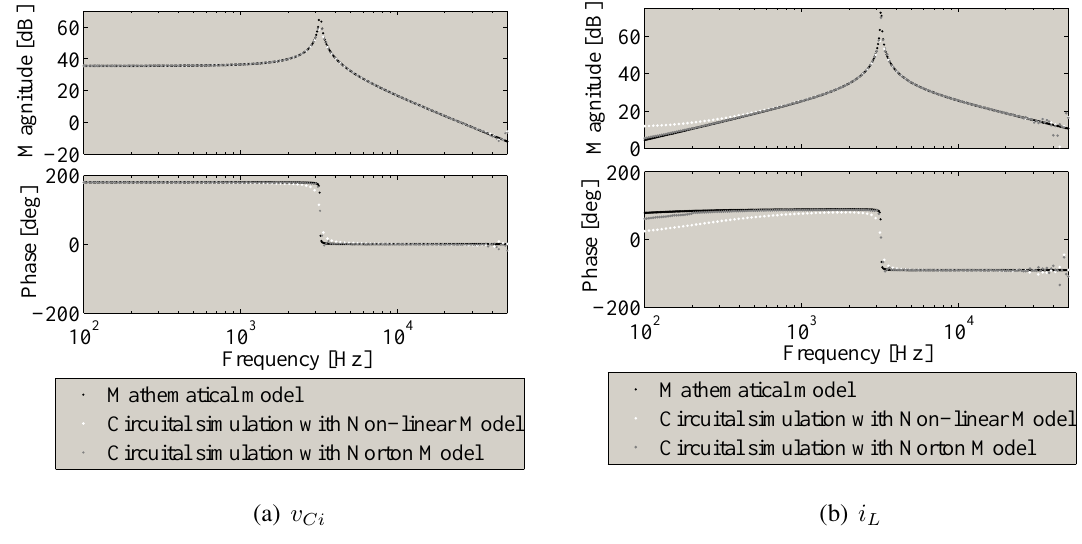
Figure 9. Model and circuit frequency responses: ideal converter with bulk voltage